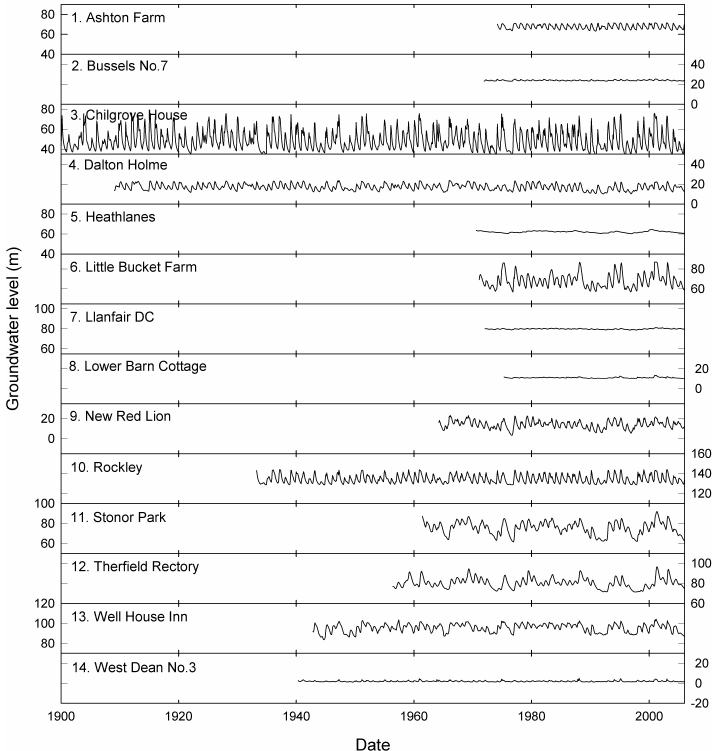
Fig. 2. Groundwater level hydrographs for the 14 study sites. Plots are for sites listed in Table 1 in alphabetical order from top to bottom.